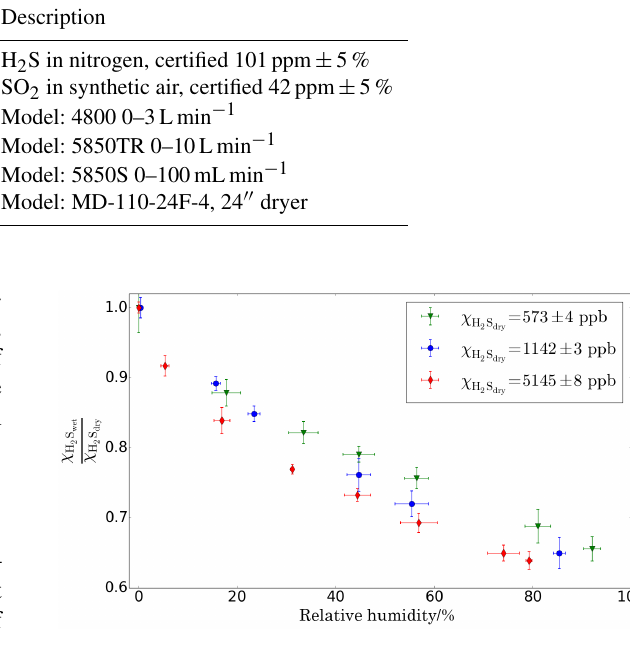
Figure 3. The ratio between measurements of H 2 S at wet and dry conditions for three initial mole fractions, plotted against the corre- sponding humidity at a temperature of 294.2 ± 0.8K. All error bars have been multiplied by 5 for better